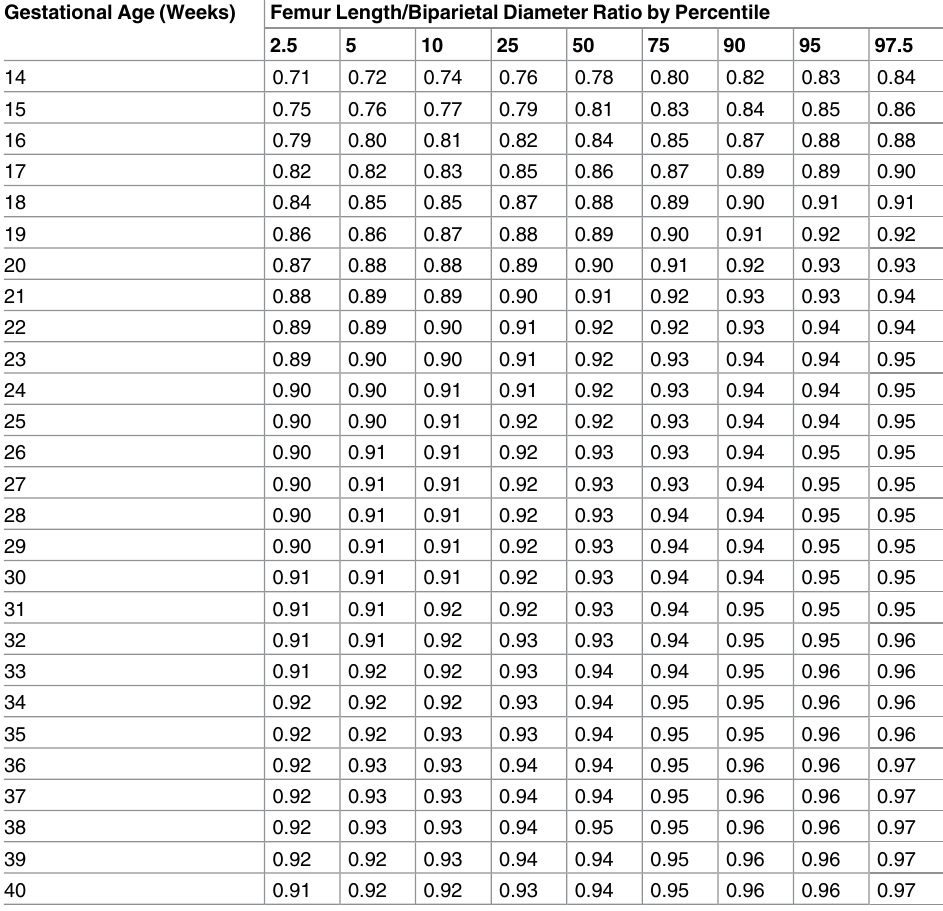
Table 13. Growth chart for fetal femur length/biparietal